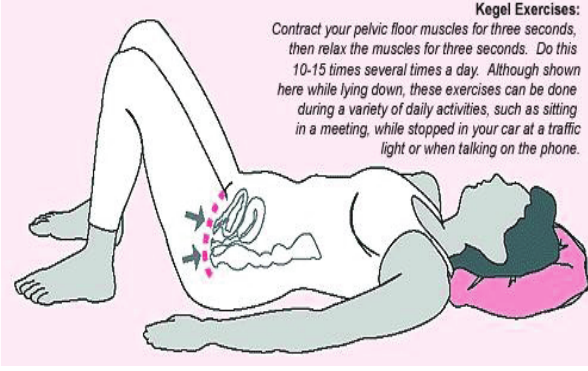
Figure-I: Method of Kegel Exercise [19]